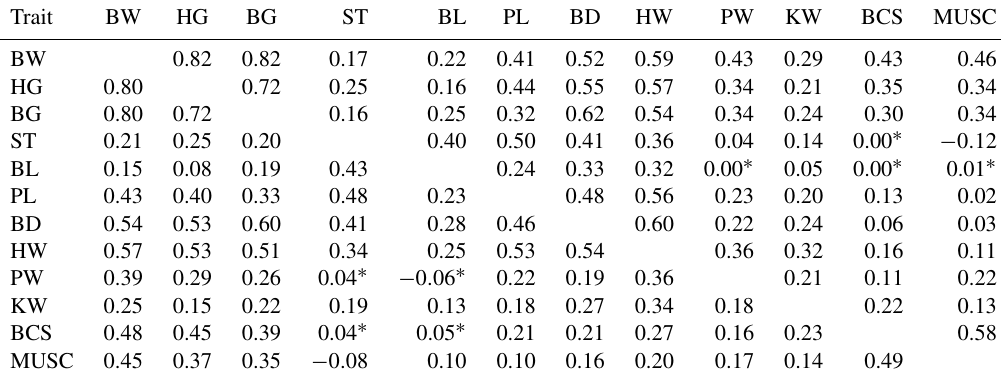
Table 3. Pearson correlation coefficients between body weight, body measurements, body condition score (BCS), and muscle score (MUSC), separated for lactation (above diagonal) and dry (below diagonal)